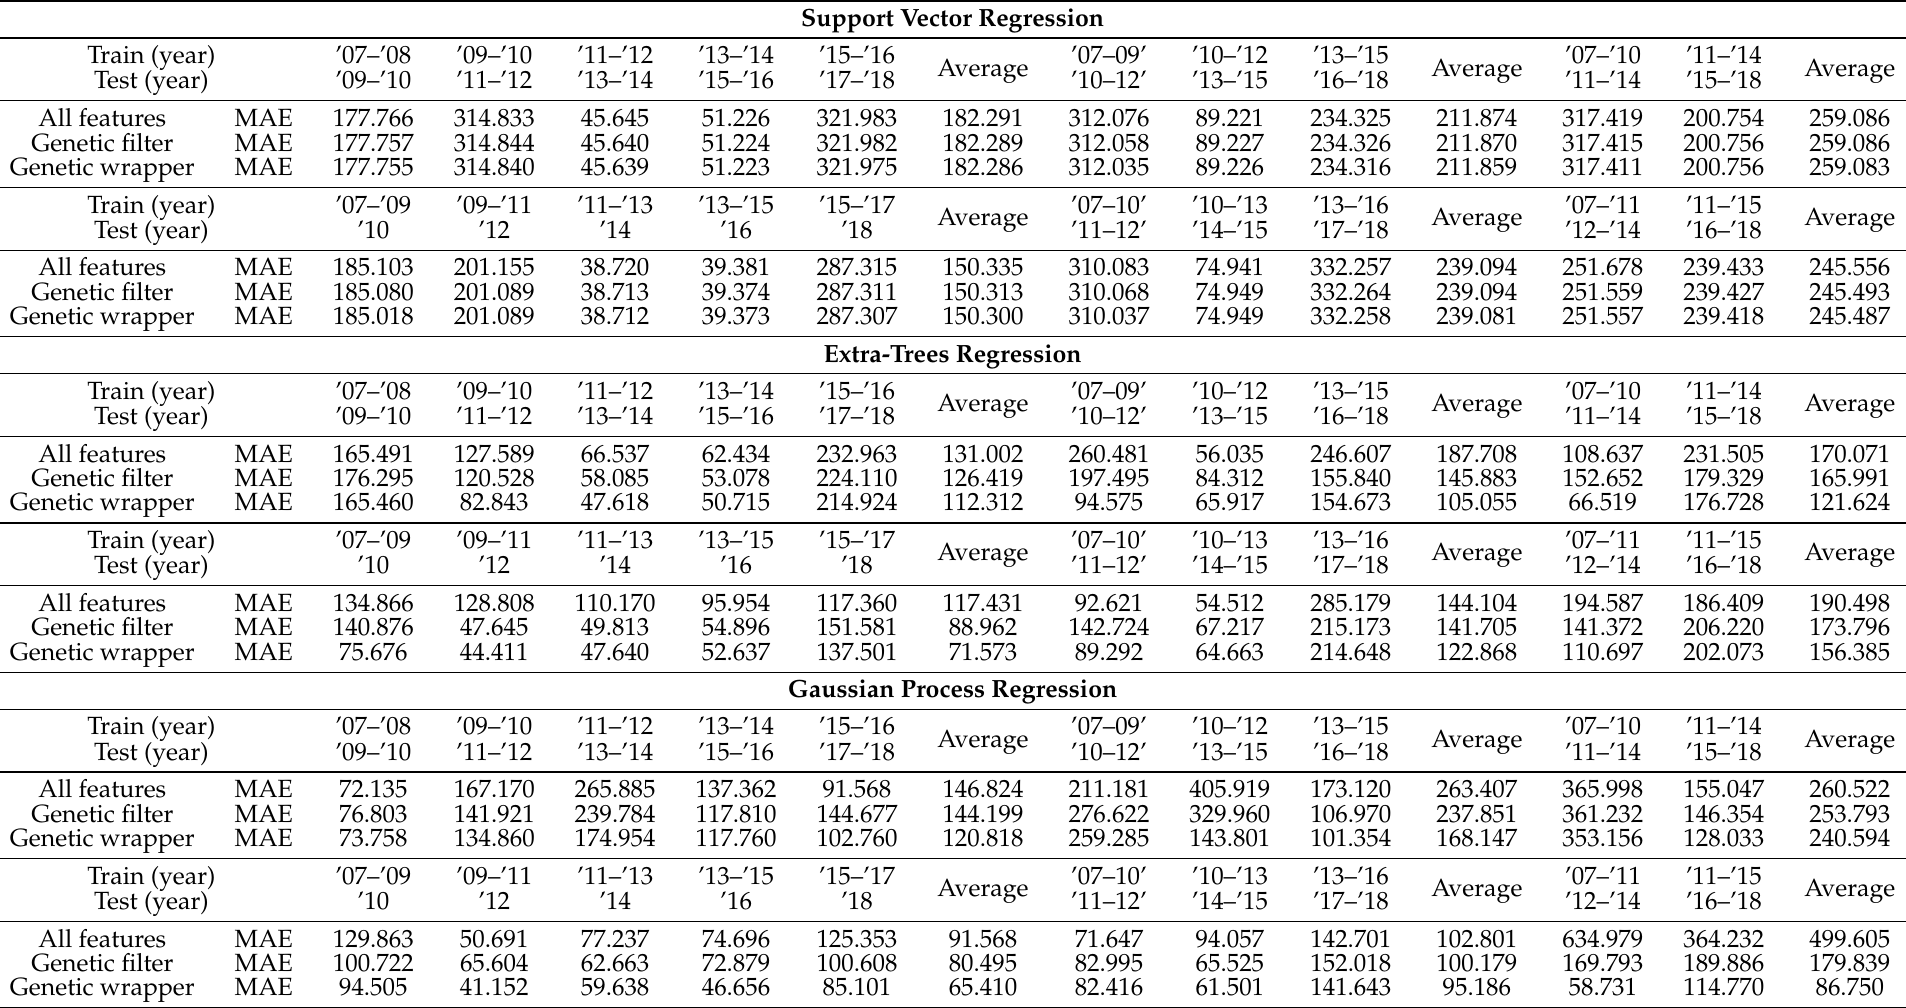
Table A1. Results of applying feature selection to